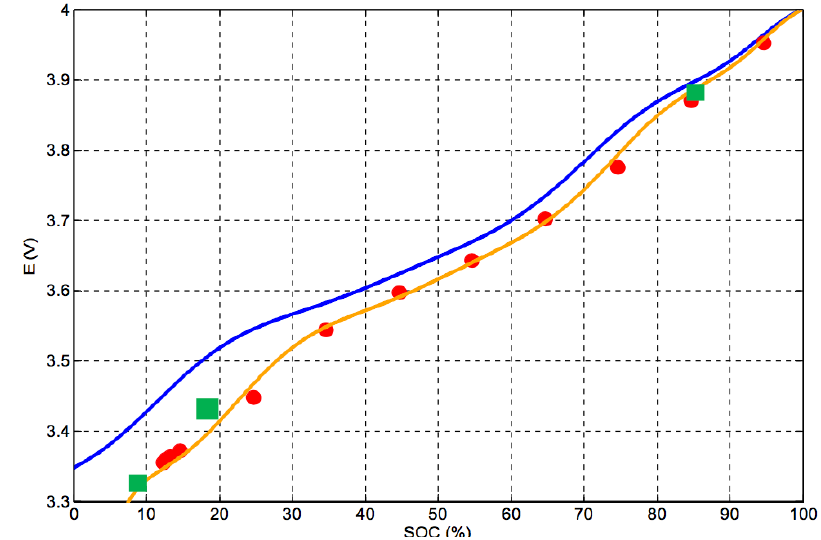
Figure 14. The SOC-OCV curve drifting after two calendar years of ageing. (Blue line is the initial OCV curve; Orange line is the aged OCV curve; Red dots are measured at 3 years; Green box are measured for parameter identification) [136].